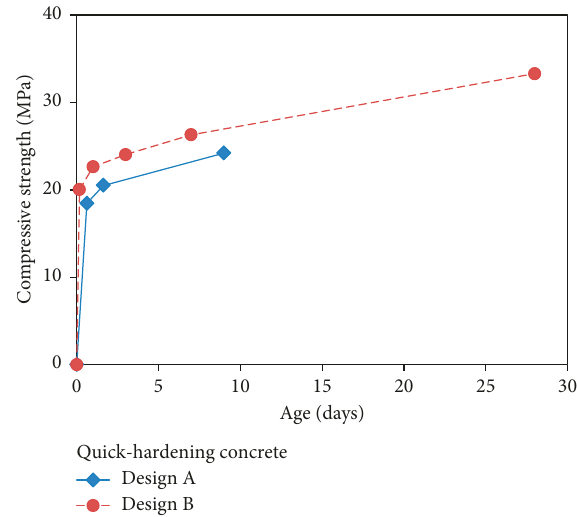
Figure 8: Compressive strength of quick-hardening